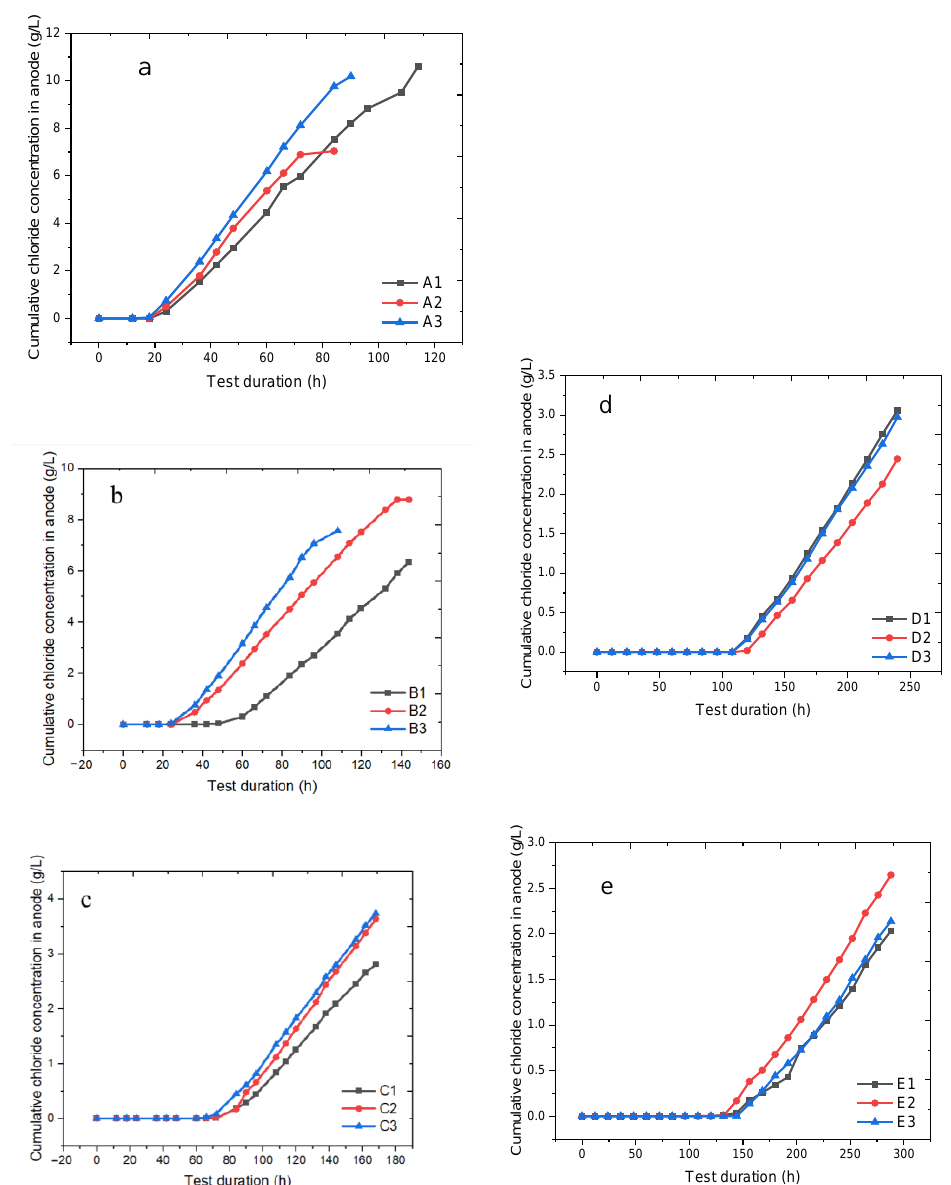
Figure 3. Cumulative chloride concentration in anode cell: ( a ) w/c=0.55 cement mortar samples, ( b ) w/c=0.50 cement mor- tar samples, ( c ) w/c=0.45 cement mortar samples, ( d ) w/c=0.40 cement mortar samples, ( e ) w/c=0.35 cement mortar sam- ples.